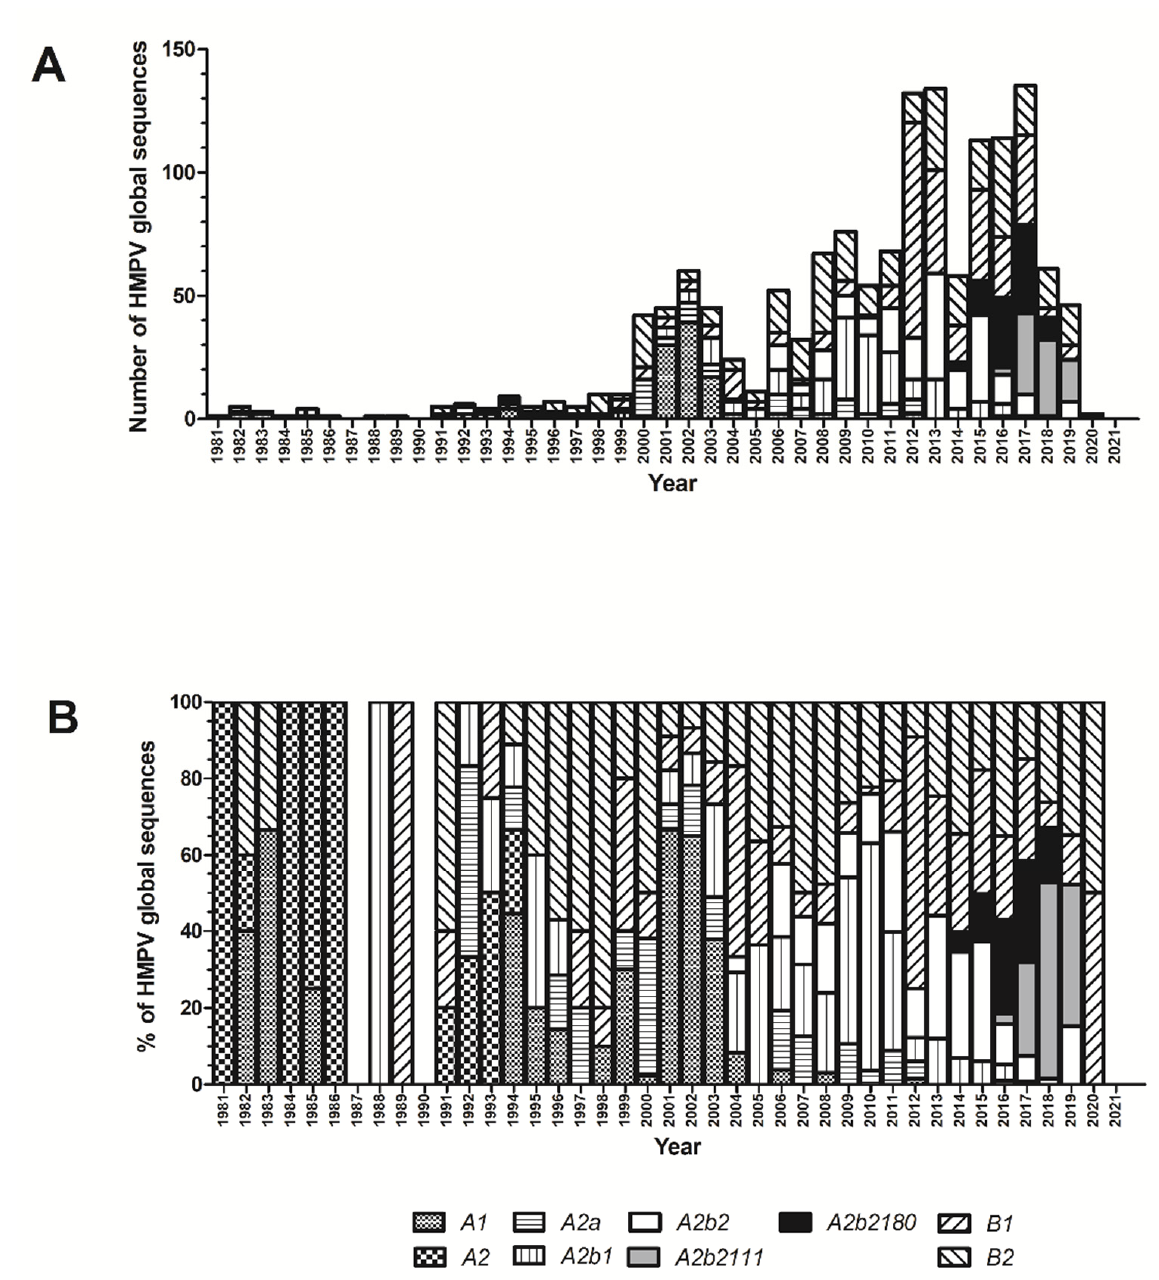
Figure 3. Number ( A ) and proportion ( B ) of global human metapneumovirus (HMPV) sequences assigned to each genotype during each year based on complete G gene ectodomain analysis for sequences available at GenBank up to December 2021. Sequences corresponding to the A2b2 genotype that contain the 111- or the 180-nucleotide duplication are represented in different solid colors.